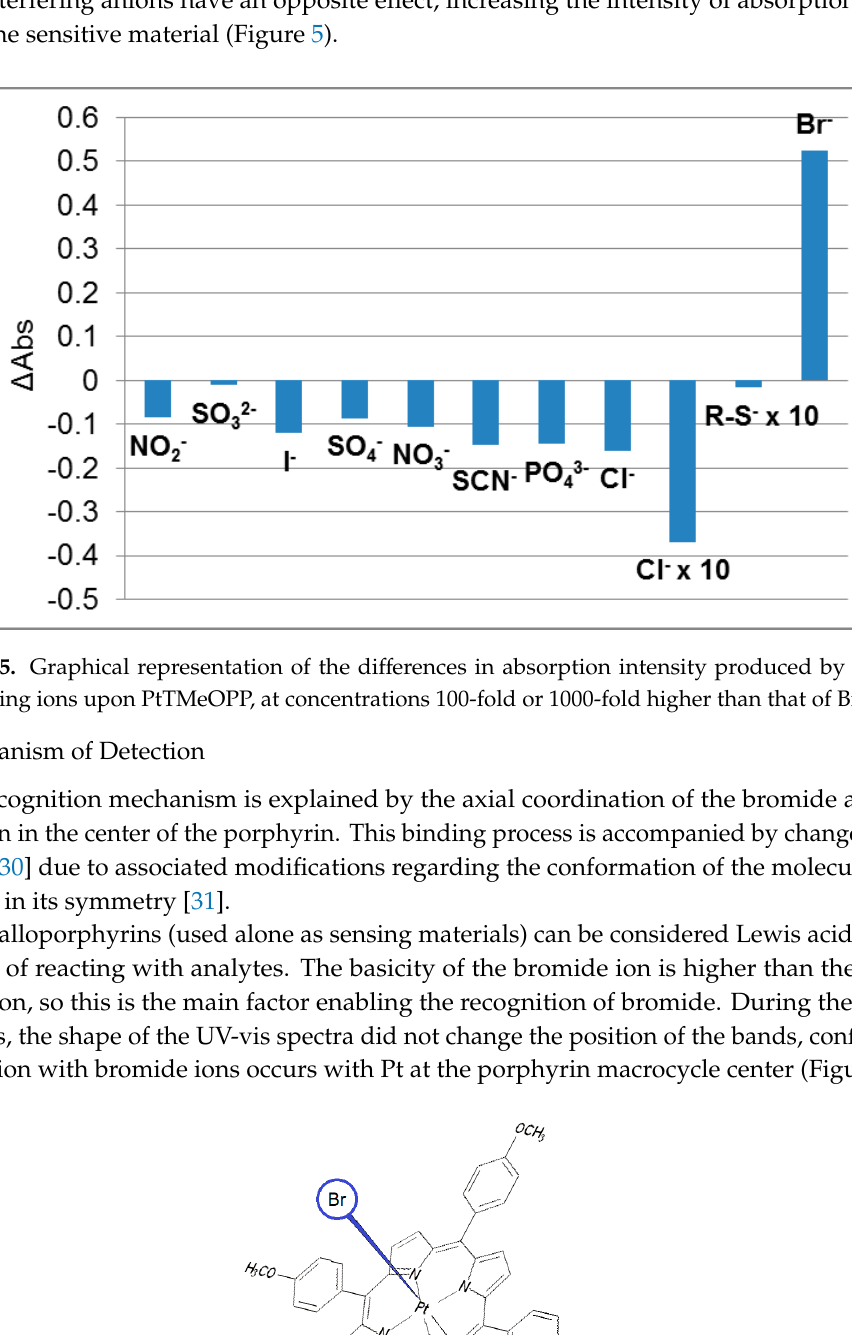
Figure 4. Overlapped UV-Vis spectra showing the effect of potential interfering anions on PtTMeOPP solution. ( a ) Detail of the Soret bands with 100-fold ( b ) and 1000-fold ( c ) higher concentration of interferences than the Br ‾ concentration.